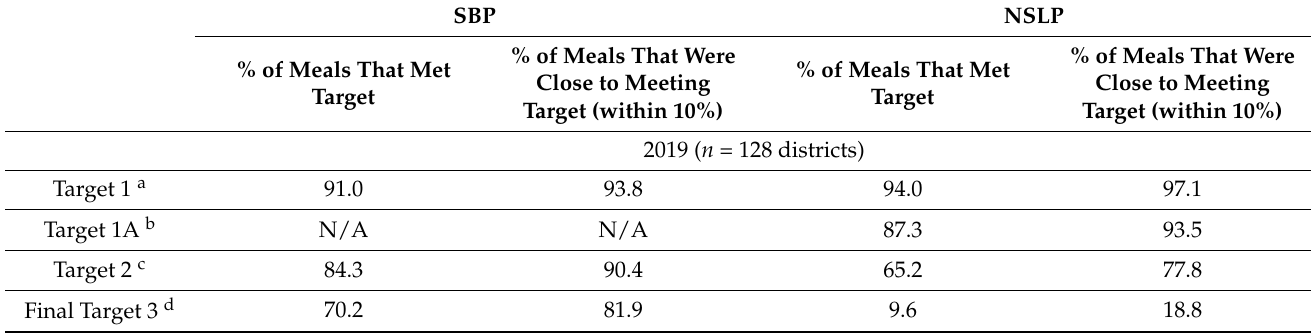
Table 2. Percent of daily meals that met or were close to meeting sodium reduction targets in a nationally representative sample of elementary (K-5) school-district breakfast and lunch menus in 2019 and